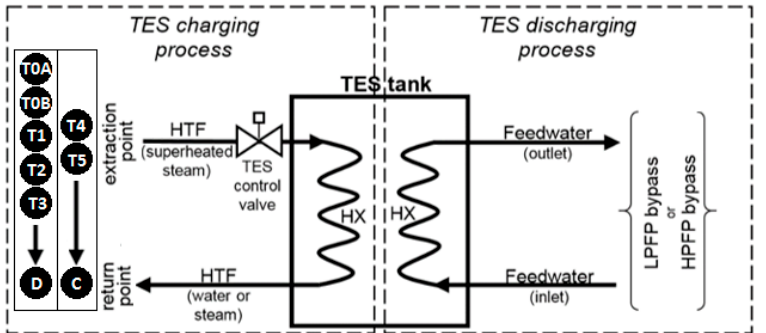
Figure 6. Thermal energy storage (TES) general description, where, HTF: heat transfer fluid; LPFP: low pressure feedwater preheater; HPFP: high pressure feedwater preheater; HX: heat exchanger; T0A–T5, C, D: these corresponds to the points in Figure 3.